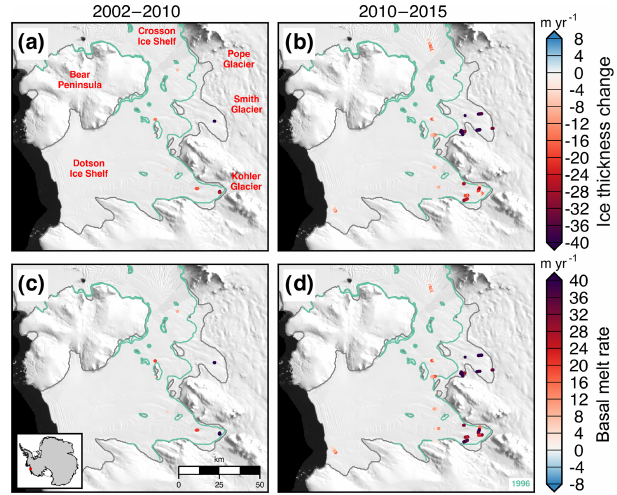
Figure 11. Ice thickness change (a–b) and estimated basal melt rates (c–d) of the Dotson and Crosson ice shelves for two periods, 2002–2010 and 2010–2015. MEaSUREs InSAR-derived Antarc- tic grounded ice boundaries are denoted in gray (Mouginot et al., 2017b). The 1996 InSAR-derived grounding line locations from Rignot et al. (2016) are delineated in green. Plots are overlaid on a 2008–2009 MODIS mosaic of Antarctica (Haran et al., 2014). The inset map denotes the location of the